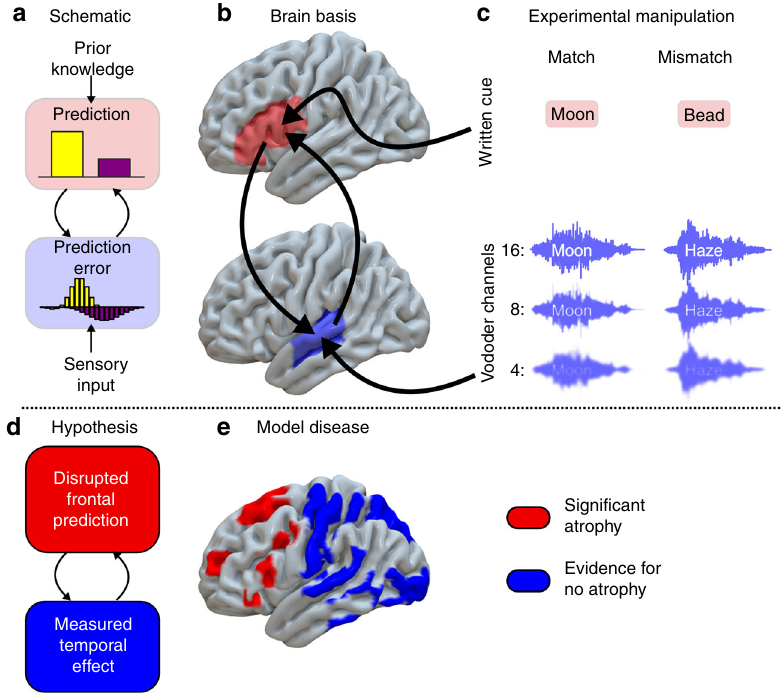
Fig. 1 An illustration of the experimental motivation. a A schematic Bayesian framework for predictive coding in speech perception. b The putative brain basis of this framework 28 . Predictions are generated in inferior frontal gyrus and/or frontal motor speech regions (pink), and instantiated in auditory regions of superior temporal lobe (pale blue). c The two dimensional experimental manipulation employed here to detect a dissociation between normal temporal lobe responses to sensory detail (number of vocoder channels) and abnormal frontal lobe responses to prior congruency. d Our experiment relies on detecting the consequences of degraded predictions in abnormal frontal brain regions by measuring their effects in normal temporal regions. e Voxel- based morphometry in our patient group. Regions coloured in red displayed consistent reductions in grey matter volume (FWE p < 0.05). Regions coloured blue had strong evidence for normal cortical volume in nfvPPA (Bayesian probability of the null > 0.7, cluster volume > 1 cm 3 ). Uncoloured (grey) areas had no strong evidence for or against